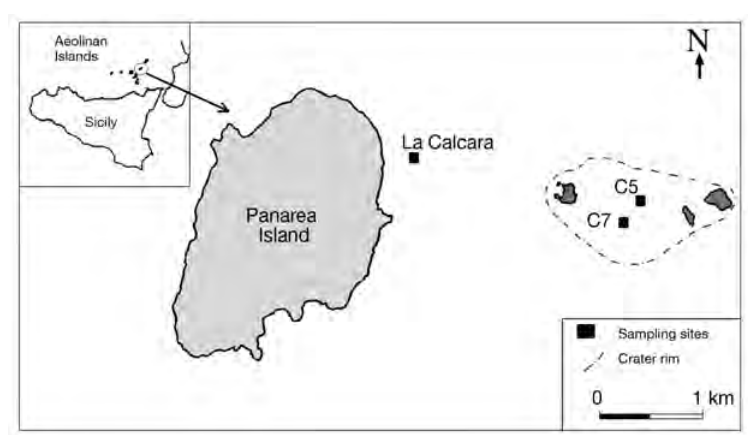
Fig. 1. Location of the hydrothermal area of Panarea Island and sampling sites.